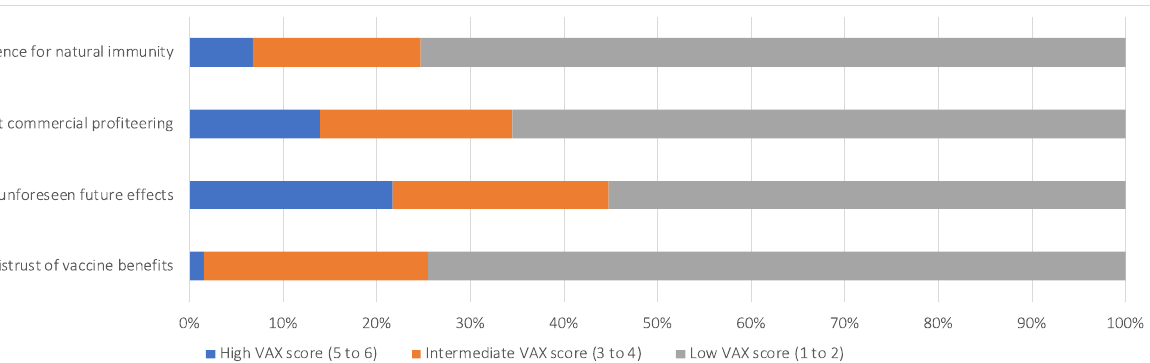
Figure 1. Levels of negative attitudes toward the vaccine. The study participants reported high, intermediate, and low VAX scores representing the levels of negative attitude toward the vaccine ( n = 1582). The question about the perception of the vaccine was derived from the four subgroups determined by the Vaccination Attitudes Examination (VAX) Scale.